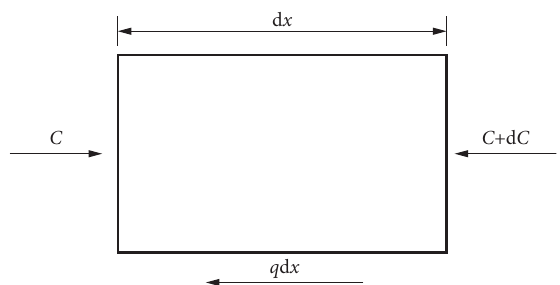
Figure 20: Te element diagram of the façade wythe.